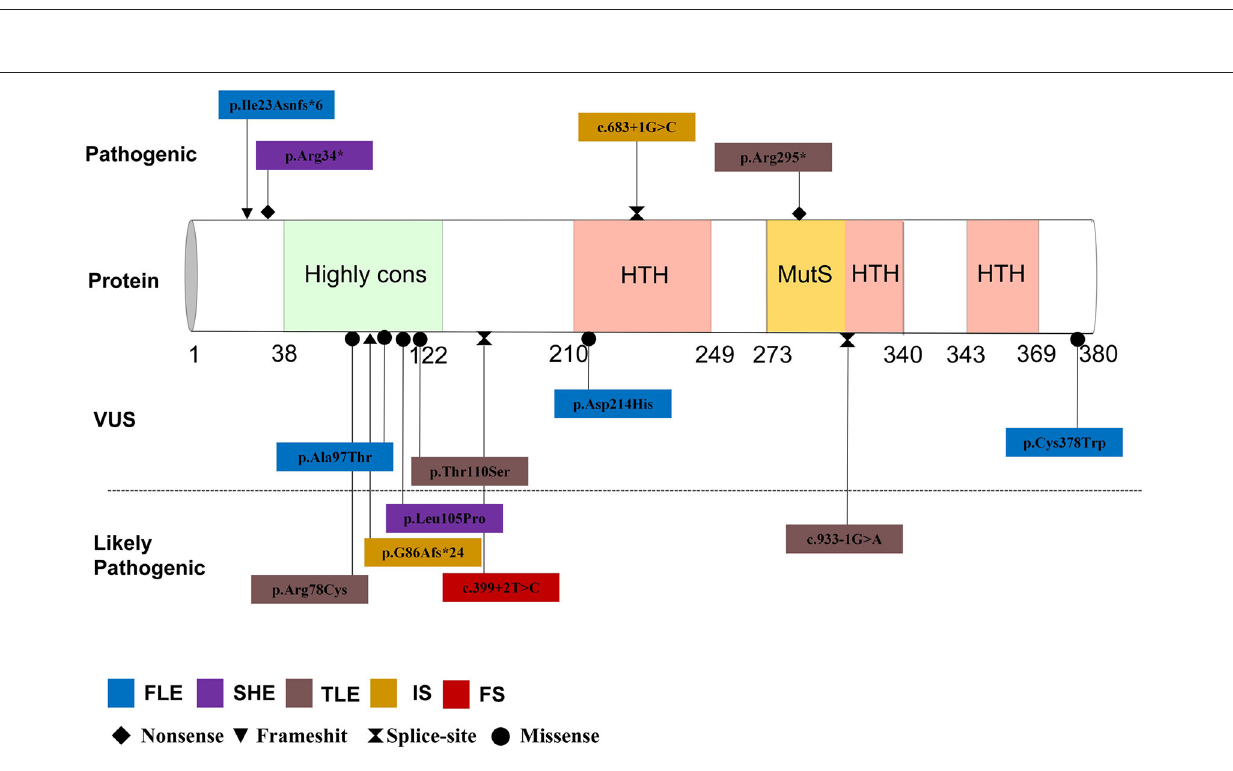
FIGURE 2 | Mutation site and phenotype spectrum of NPRL2